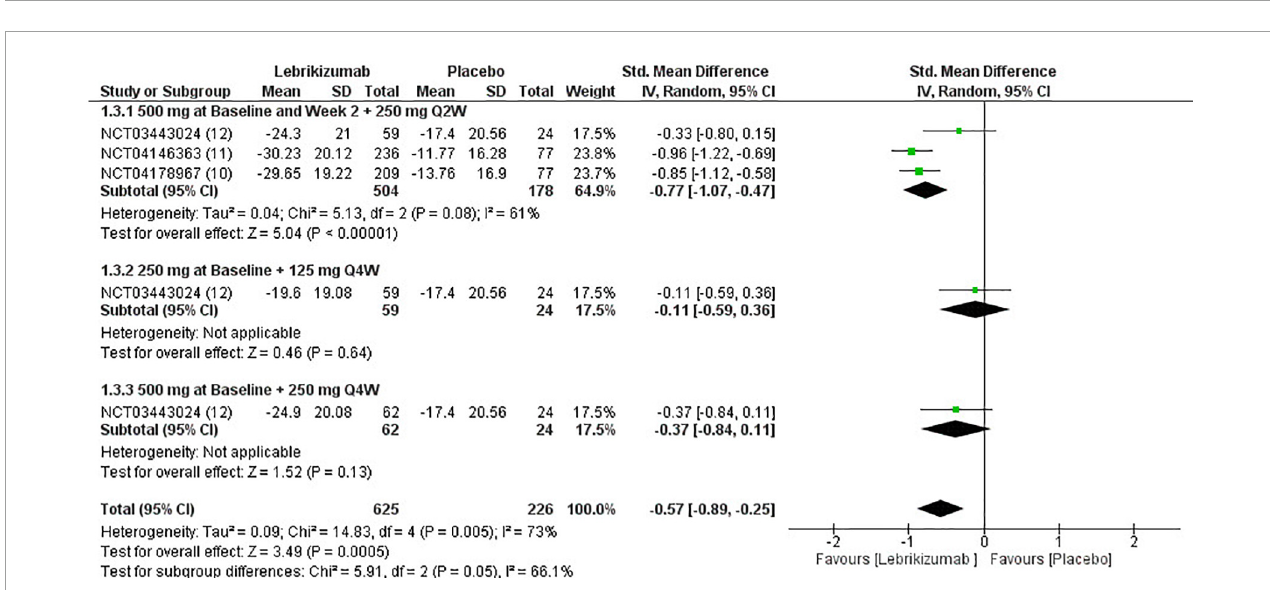
FIGURE7 Forest plot of the percentage change in BSA. CI, confidence interval; IV, inverse variance; SMD, standardized mean difference; SD, standard deviation; Q2W, every 2 weeks; Q4W, every 4 weeks.